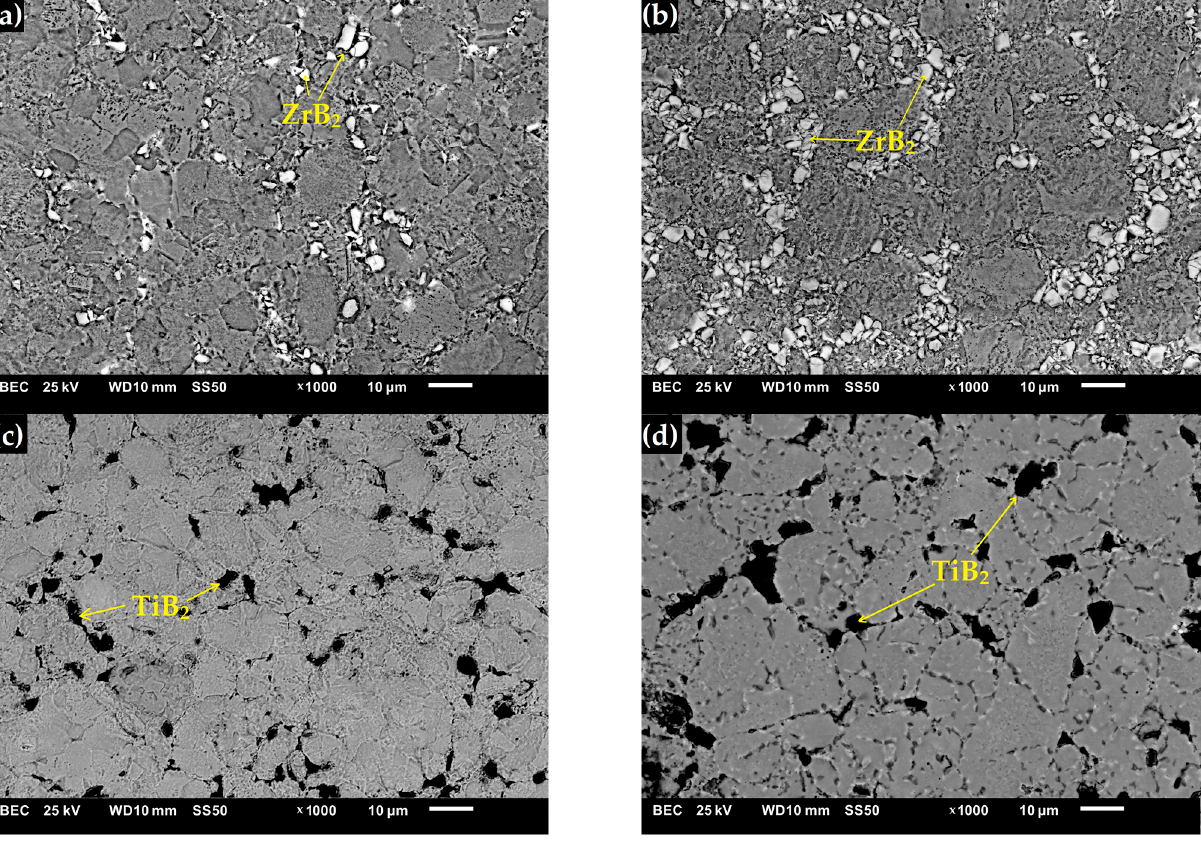
Figure 3. The SEM micrograph of the composites with: ( a ) 5% ZrB 2 , ( b ) 10% ZrB 2, ( c ) 5% TiB 2 , and ( d ) 10% TiB 2 .